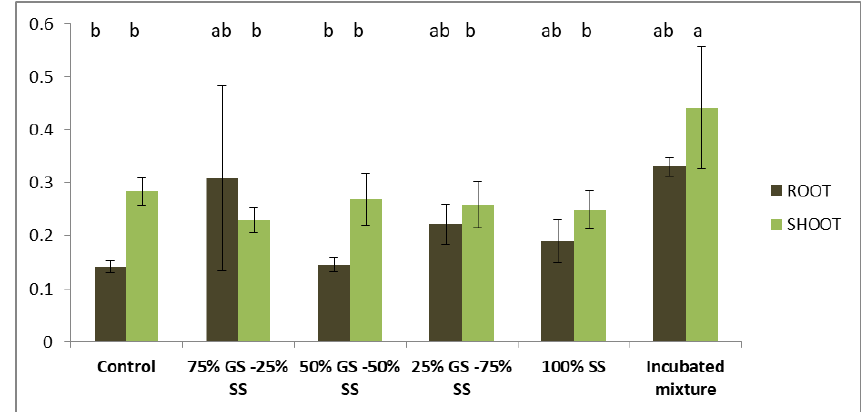
Figure 1. Dry weight of corn plants (g) (averaged value ± standard error; n = 4). Letters are comparing the treatments.